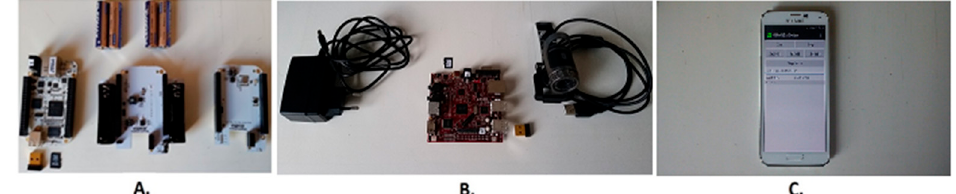
Figure 7. Smart home equipment. ( A ) BeagleBone with weather and battery capes, USB-WiFi, and SD memory card. ( B ) BeagleBoard with USB-Camera, power supply, USB-WiFi, and SD memory card. ( C ) Android smart phone device with the user’s smart home application.